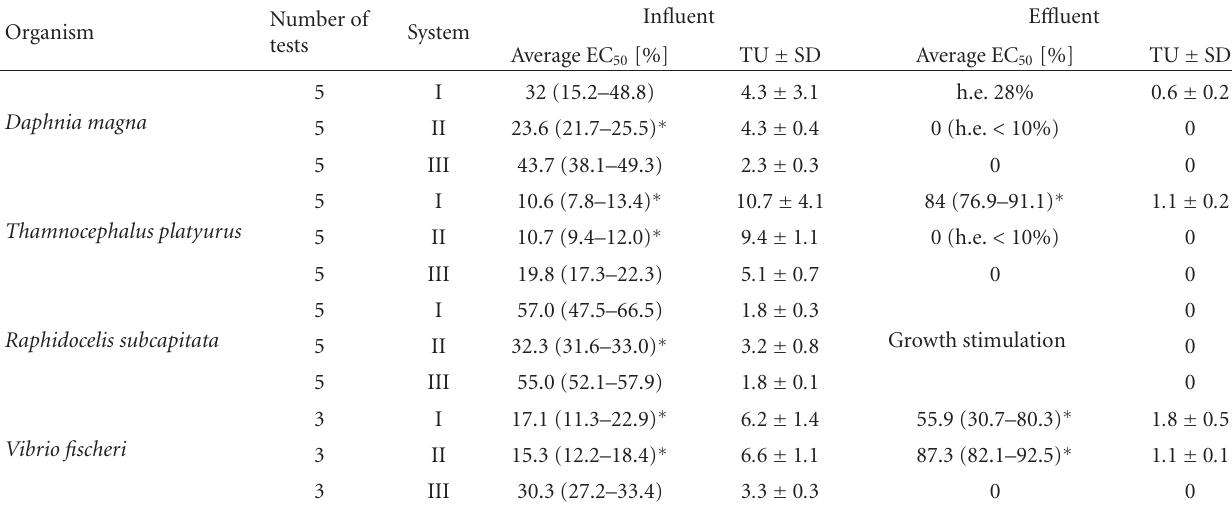
Table 9: Toxicity of raw and treated wastewater (10% of leachate in influent I and II; the 95% confidence limit in parenthesis).